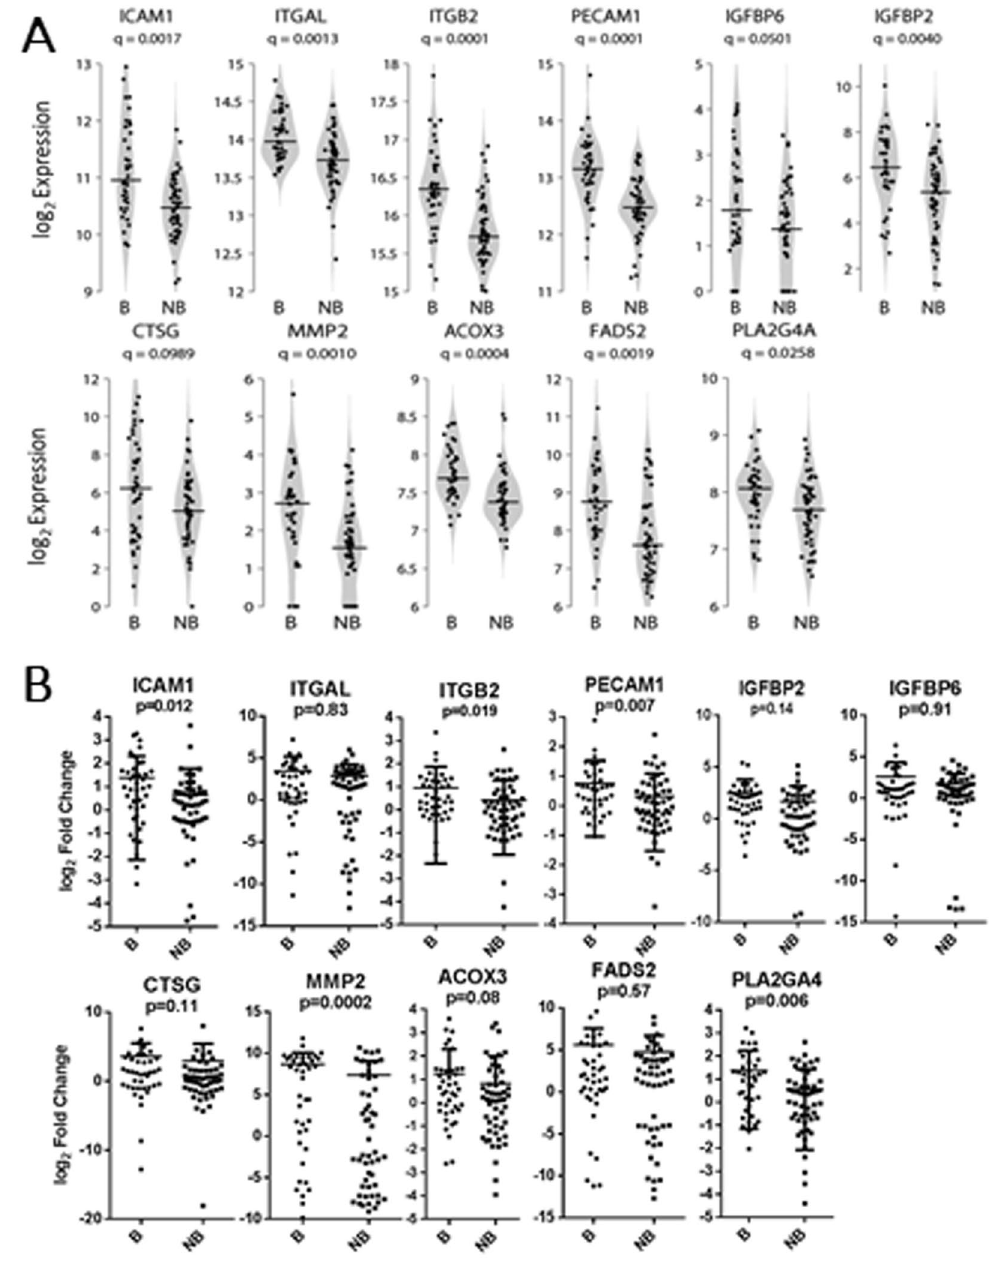
Figure 3. Expression of Genes Predictive for Bacterial Involvement in LRTI. ( A) Violin plots of RNASeq- based expression data for 11 selected genes, from 3 canonical pathways, that provide predictive value for identifying bacterial involvement in lower respiratory track infections. Q-values for differential expression between bacterial and non-bacterial groups are indicated beneath the gene names. Horizontal lines indicate group medians. ( B ) Quantitative reverse transcriptase-polymerase chain reaction (qPCR)- based expression data for each of the 11 genes. P-values for differential expression between bacterial and non-bacterial groups are indicated beneath the gene names. Horizontal lines indicate group